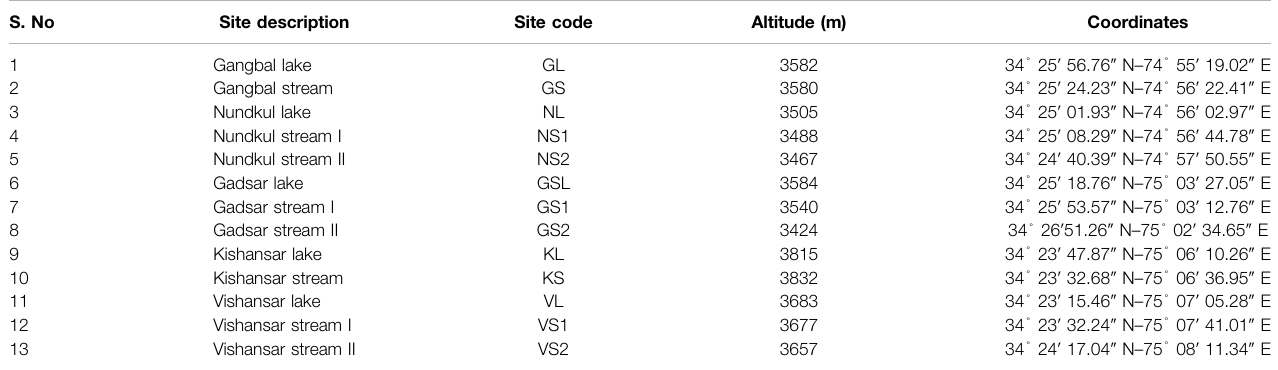
TABLE 1 | Study area site